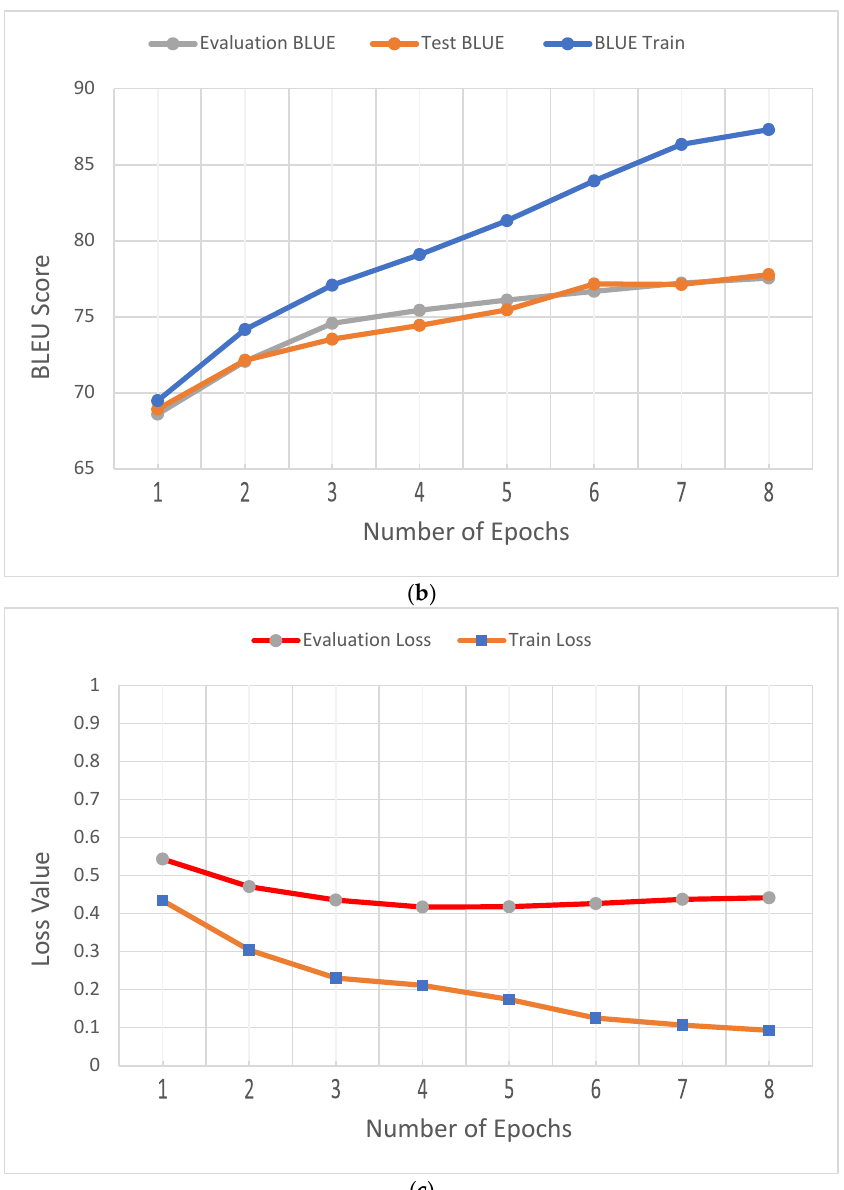
Figure 5. Performance of the BART large model for the Django dataset. ( a ) Accuracy of evaluation, test, and train datasets. ( b ) BLEU of evaluation, test, and train datasets. ( c ) Loss of evaluation and train dataset.